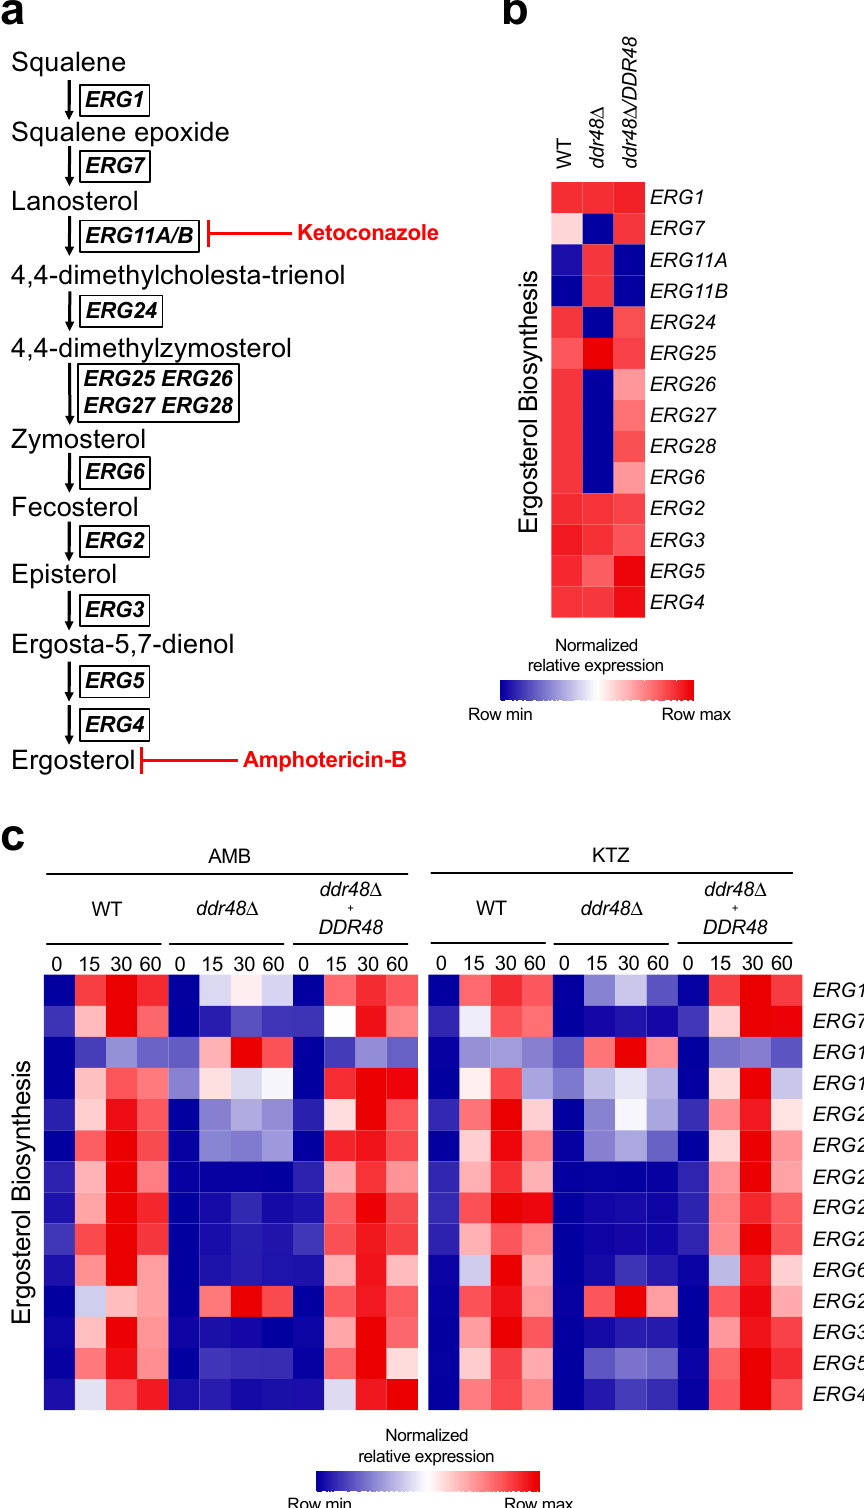
Figure 5. DDR48 -Depleted Histoplasma Yeasts Contain an Aberrant Ergosterol Biosynthesis Pathway That is Exacerbated by Antifungal Treatment. ( a ) Ergosterol biosynthesis pathway utilized by H. capsulatum yeasts with representative genes and their function. The step at which each class of antifungals interferes with the pathway are shown in bold red. ( b ) Transcriptional profile of wildtype (WT), ddr48 ∆ , and ddr48 ∆ / DDR48 yeasts grown in basal cell culture medium (HMM) and